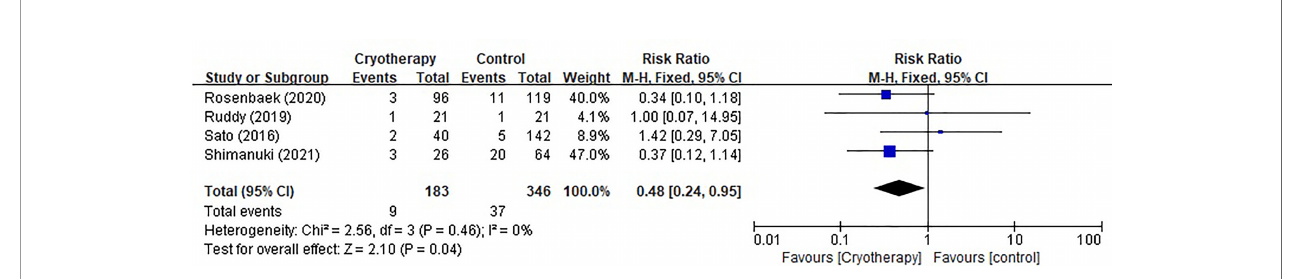
FIGURE 4 | Forest plots of preventive effect of cryotherapy on incidence of taxane dose reduction for TIPN.